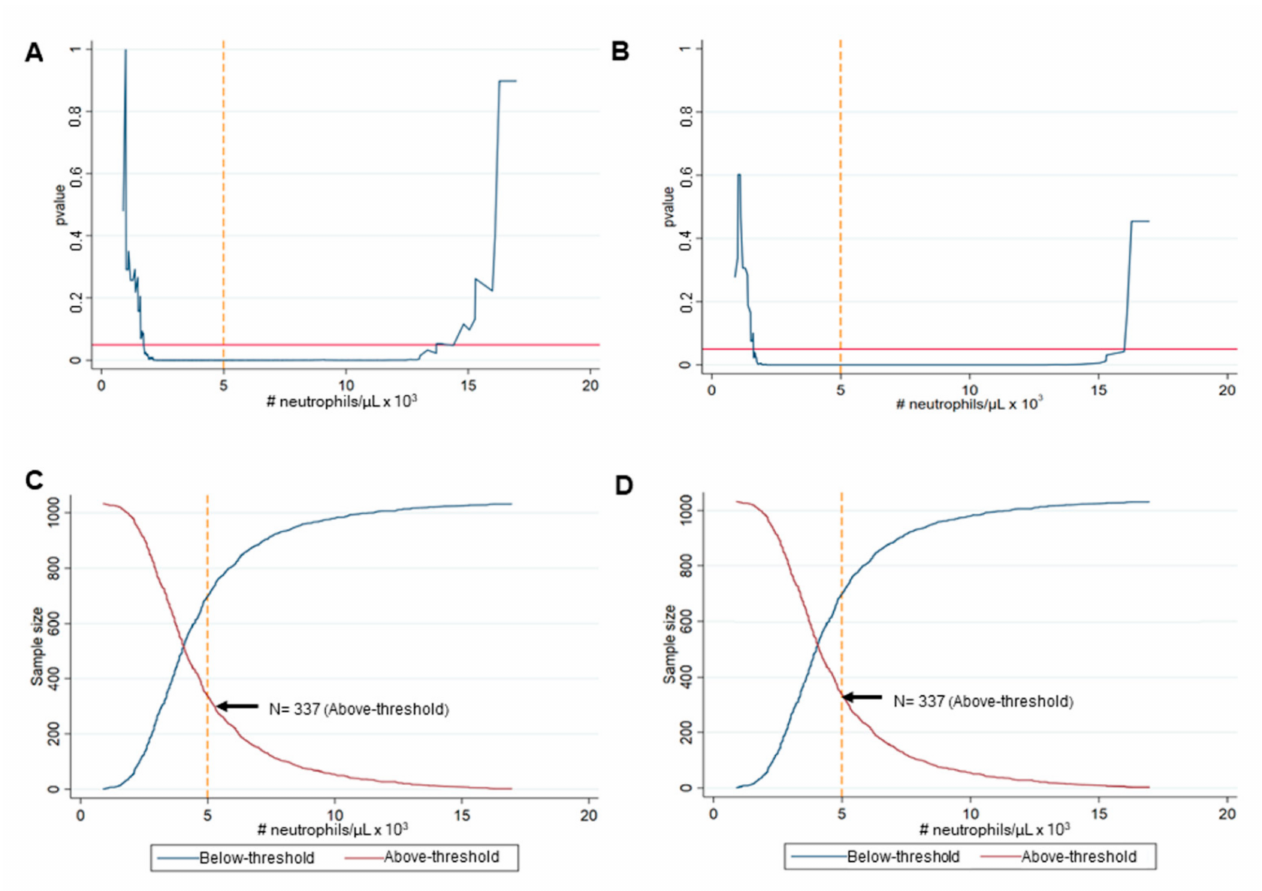
Figure 2. Identification of the neutrophil threshold for patient clustering. Classification of neu- trophil counts based on ( A ) FACED and ( B ) EFACED: Statistical significance resulting from the Mann–Whitney U test as a measure of the corresponding p-value for varying thresholds The statisti- cal significance threshold p = 0.05 is represented in the horizontal solid red line, while the vertical yellow dashed line represents the optimal threshold of neutrophil counts Number of patients in the above-threshold cluster based on ( C ) FACED and ( D ) EFACED. Black arrows point toward the percentage of the patients’ threshold in which the most balanced cluster sizes were